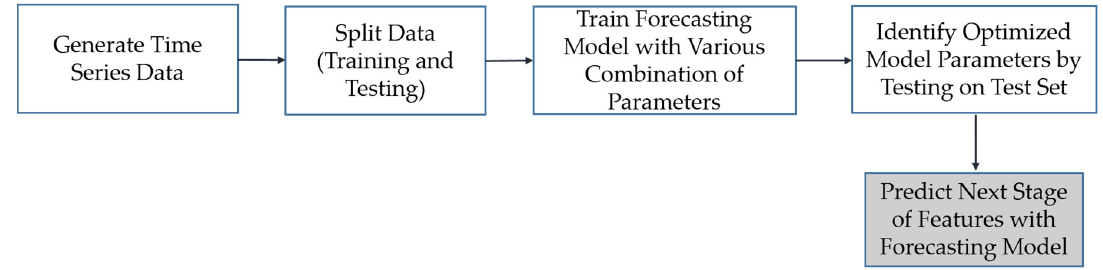
Figure 6. Overall time-series modeling methodology.